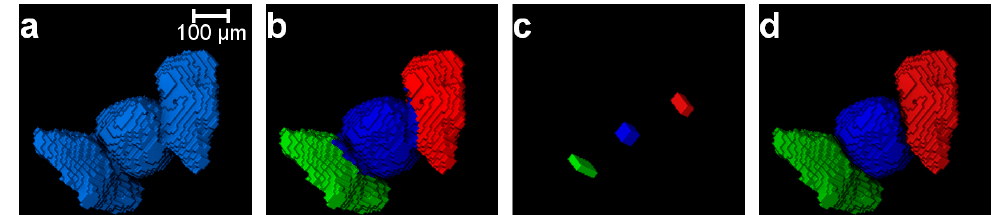
Figure 6. Determination of acceptable marker size for the separation of particles: ( a ) a group of particles; ( b ) cluster analysis; ( c ) extraction of markers; and ( d ) separated particles.